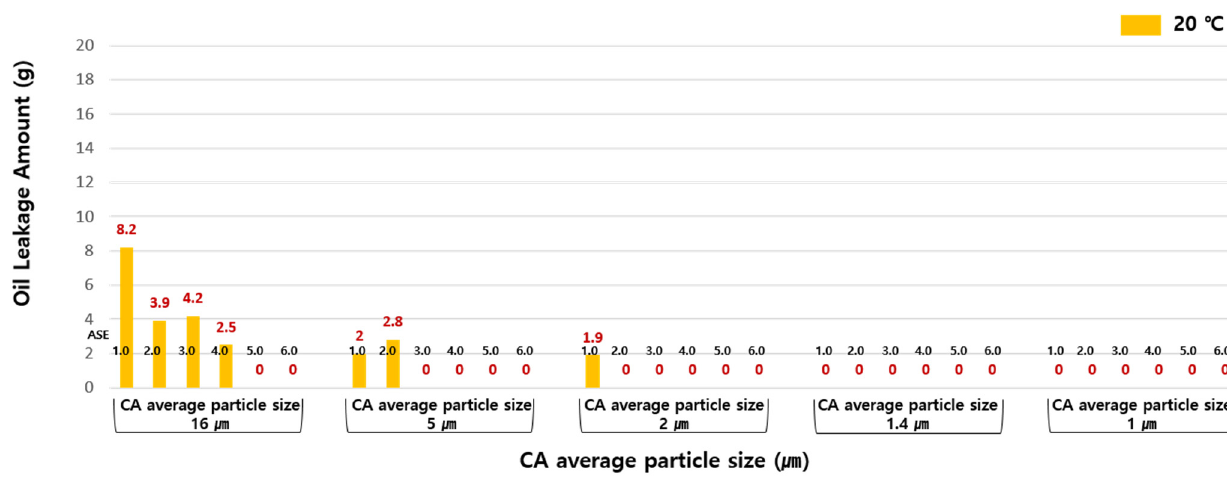
Figure 9. Graph of oil leakage stability test results (20 °C). Table 8. The 40 °C oil leakage stability test results (g).